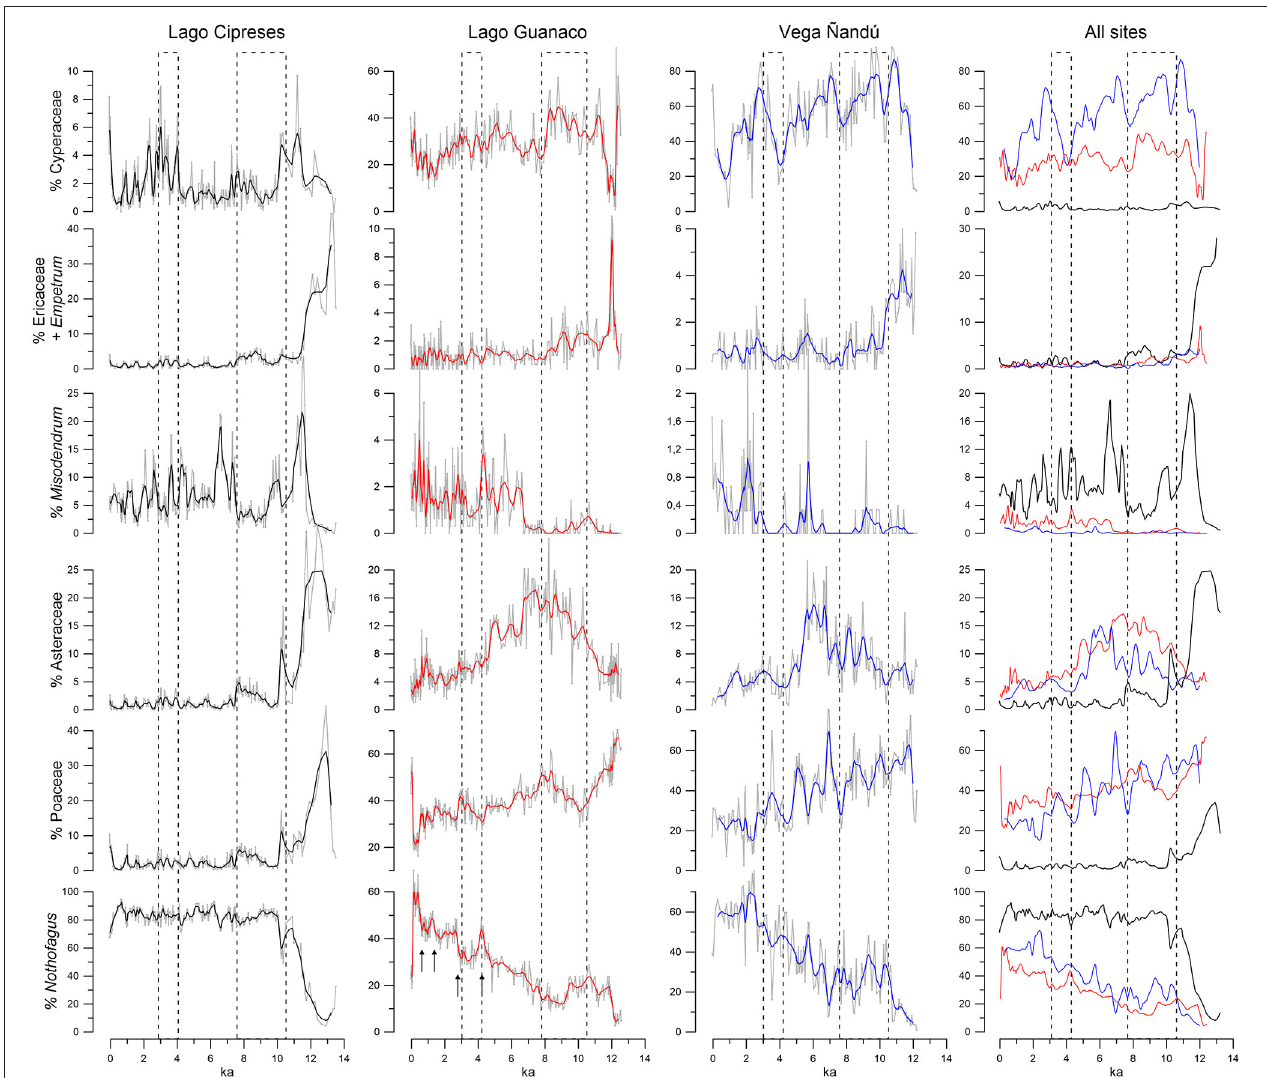
FIGURE 3 | Percentage variation of selected taxa in the sites discussed in this study (fine gray lines) and weighted running means of individual taxa (solid colored lines). The dashed vertical rectangles highlight two conspicuous warm-dry intervals discussed in the Lago Cipreses record.